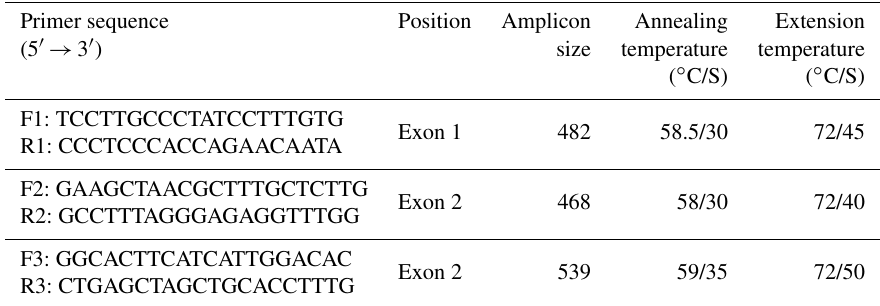
Table 1. Distribution of genotyped samples from ewes and rams of four Iranian sheep breeds. Ewe Breed Ram Sum Infertile Singleton Doubleton Tripleton Shal 1 13 19 0 16 49 Ghezel – 20 30 – 7 57 Afshari – 38 5 – 12 55 Lori-Bakhtiari 1 34 49 3 9 96 Total number 2 105 103 3 44 257